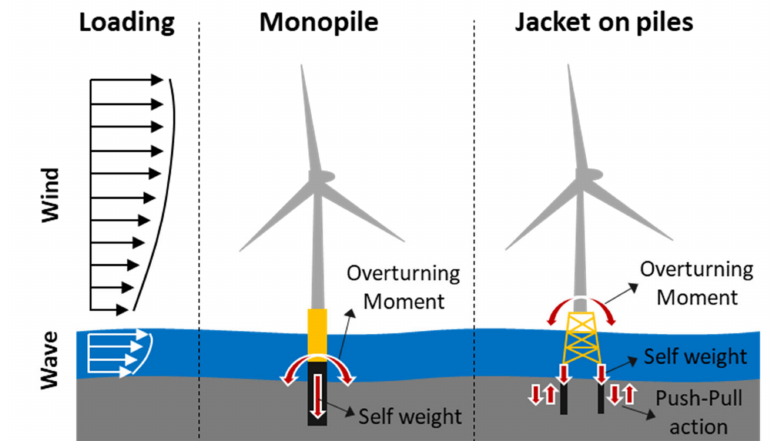
Figure 2. Load transfer in different foundation